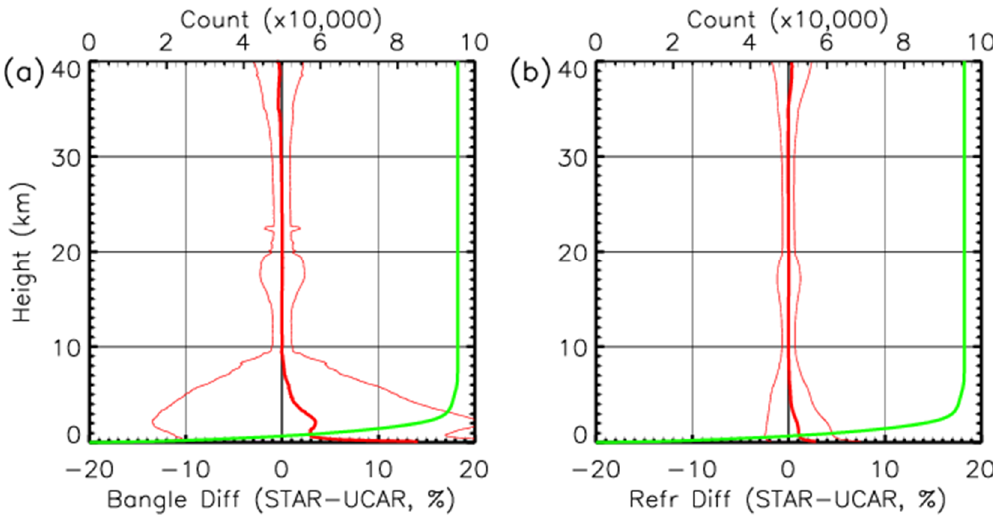
Figure 15. ( a , b ) Same as Figure 12, but for the STAR–UCAR fractional difference. Although STAR and UCAR derived RO products use the same L1b data, the methods used at different data processing steps can cause structural differences in the data products, especially in the lower troposphere where the uncertainties are large in the retrieved bending angles. Compared to UCAR below ~8 km, the positive bias of STAR retrievals is mostly due to filtering the raw data used in the excess phase’s preprocessing. Comparing the fractional bending angle and refractivity difference between STAR and UCAR for different latitude and SNR ranges are shown in Figure 16. Comparison between STAR and UCAR shows a consistent positive bias of STAR profile compared in the lower troposphere. This difference is caused by the differences in the ways signal noise is handled in the processing of the excess phases. Both the bias and the standard deviation are smallest in the mid-latitudes in either hemisphere, with the largest bias in the tropics between 10 ◦ N–10 ◦ S. The dependence on SNR that both the bias and the standard deviations are smallest at low SNR values < 500 v/v . Above 500 v/v , there is no significant difference in the bias, but the standard deviation shows a weak SNR dependence. The smaller bias and standard deviations at low SNR can be attributed to the weaker penetration depth of low SNR signals in the atmosphere with complex water vapor structure in the lower troposphere. Signals with SNR can penetrate deeper in these complex tropospheric layers with greater horizontal water vapor variations causing larger biases and standard